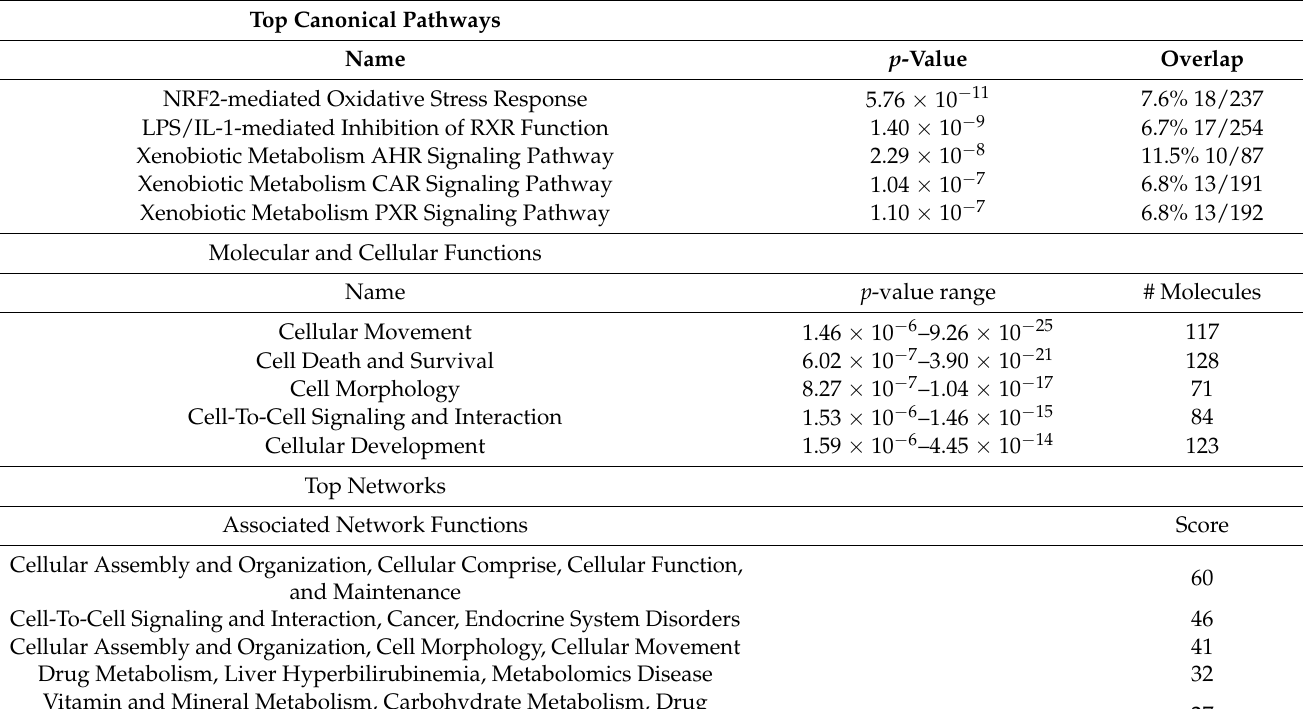
Figure 2. Effect of S4 inhibitor on the viability of Caki-2 cells. Caki-2 cell cultures were treated with 4-(3 ′ -(3”, 5”-dimethylphenyl)ureido)phenyl sulfamate (S4) in normoxic and hypoxic conditions in four replicate experiments. Additional cultures were treated with DMSO as controls. Following incubation, cell viability was assessed using the Trypan Blue assay. DMSO has no effect on the viability of Caki-2 cells, whereas S4 significantly reduces cell viability under hypoxic and normoxic conditions. Cell viability is significantly reduced under hypoxic conditions as demonstrated by one-way ANOVA using Šid á k’s multiple comparisons test ( p = 0.0491). Significantly different cell viability depicted by an asterisk p < 0.05. Table 2. Summary of IPA Analysis of differentially expressed proteins between Caki-1 and Caki-2 cells. The top five canonical pathways, the top five molecular and cellular functions, and the top five networks and their functions are